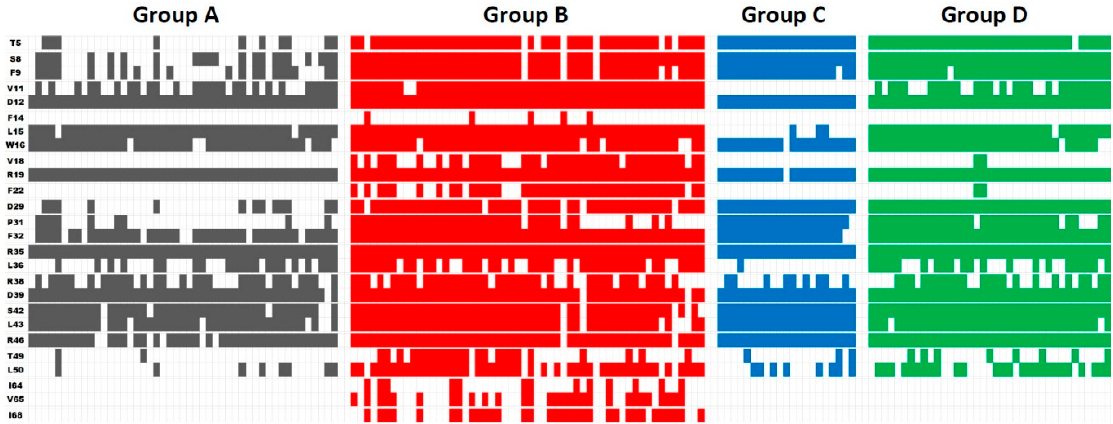
Figure A1. The most involved RBD residues and the four groups of pockets. Correspondence between the 26 most involved RBD residues (rows) and the 159 FL groove-pockets (columns). The selected residues are indicated on the left, and FL pockets are ordered and colored according to their group.